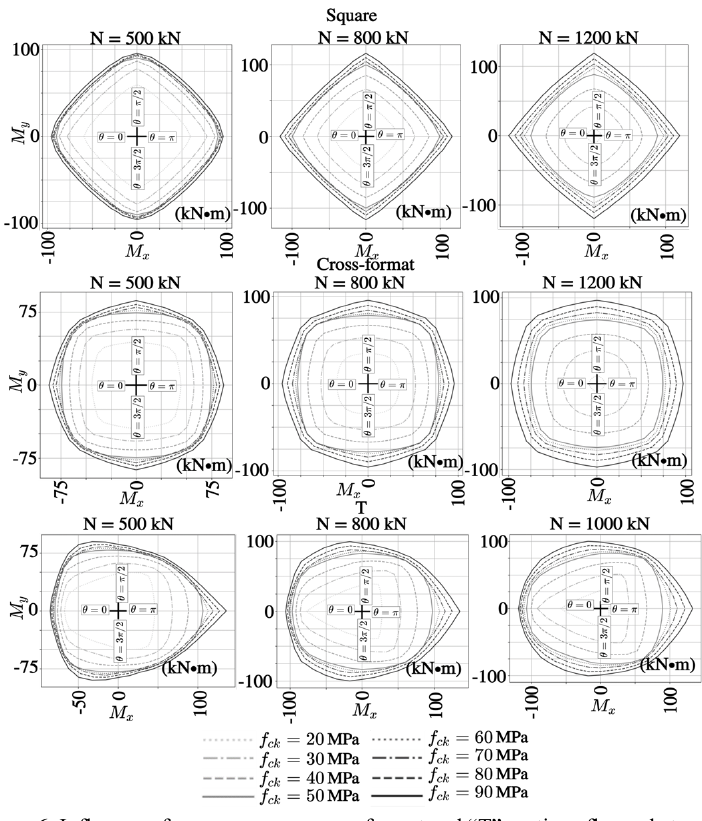
on square, cross-format and “T” sections flexural strength. Figure 6. Influence of ck f